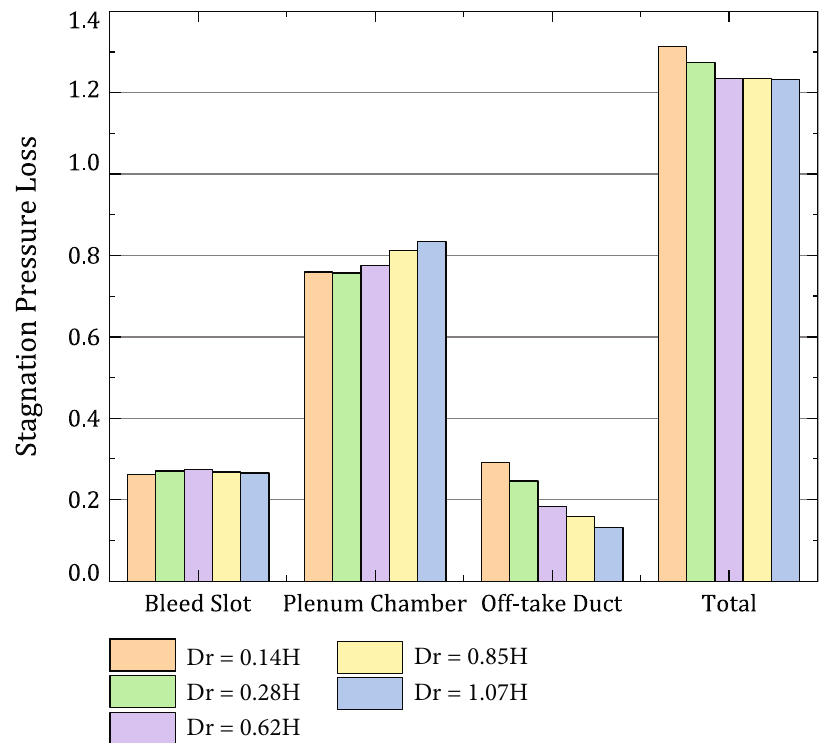
Figure 13: SPL coe ffi cient of each part of bleed system with di ff ering radial height.